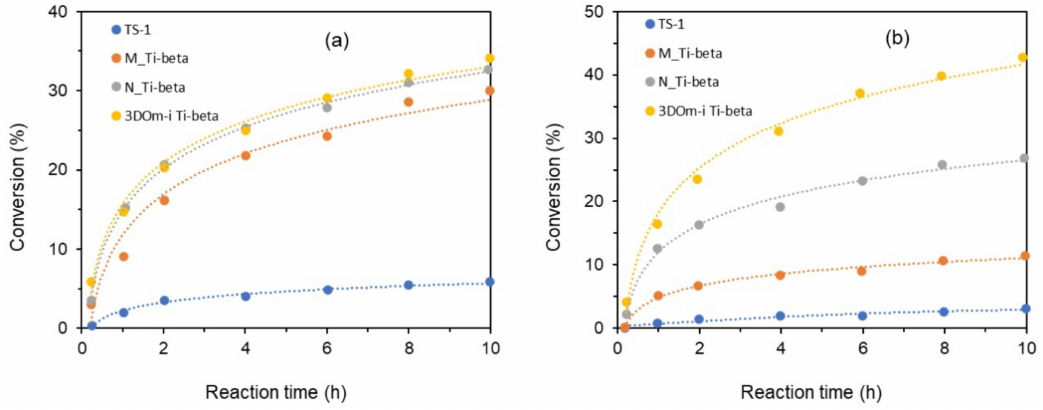
Figure 24. Conversion of cyclohexene ( a ) and cyclooctene ( b ) over 3DOm-I Ti-beta and other compar- ison catalysts, as a function of reaction time. [66].